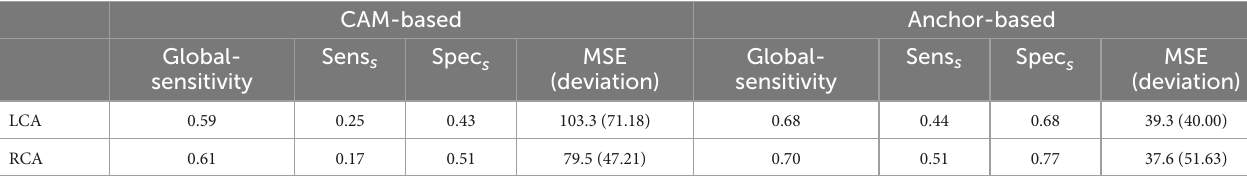
TABLE 5 Performance of the stenosis localization algorithms for the LCA and RCA.